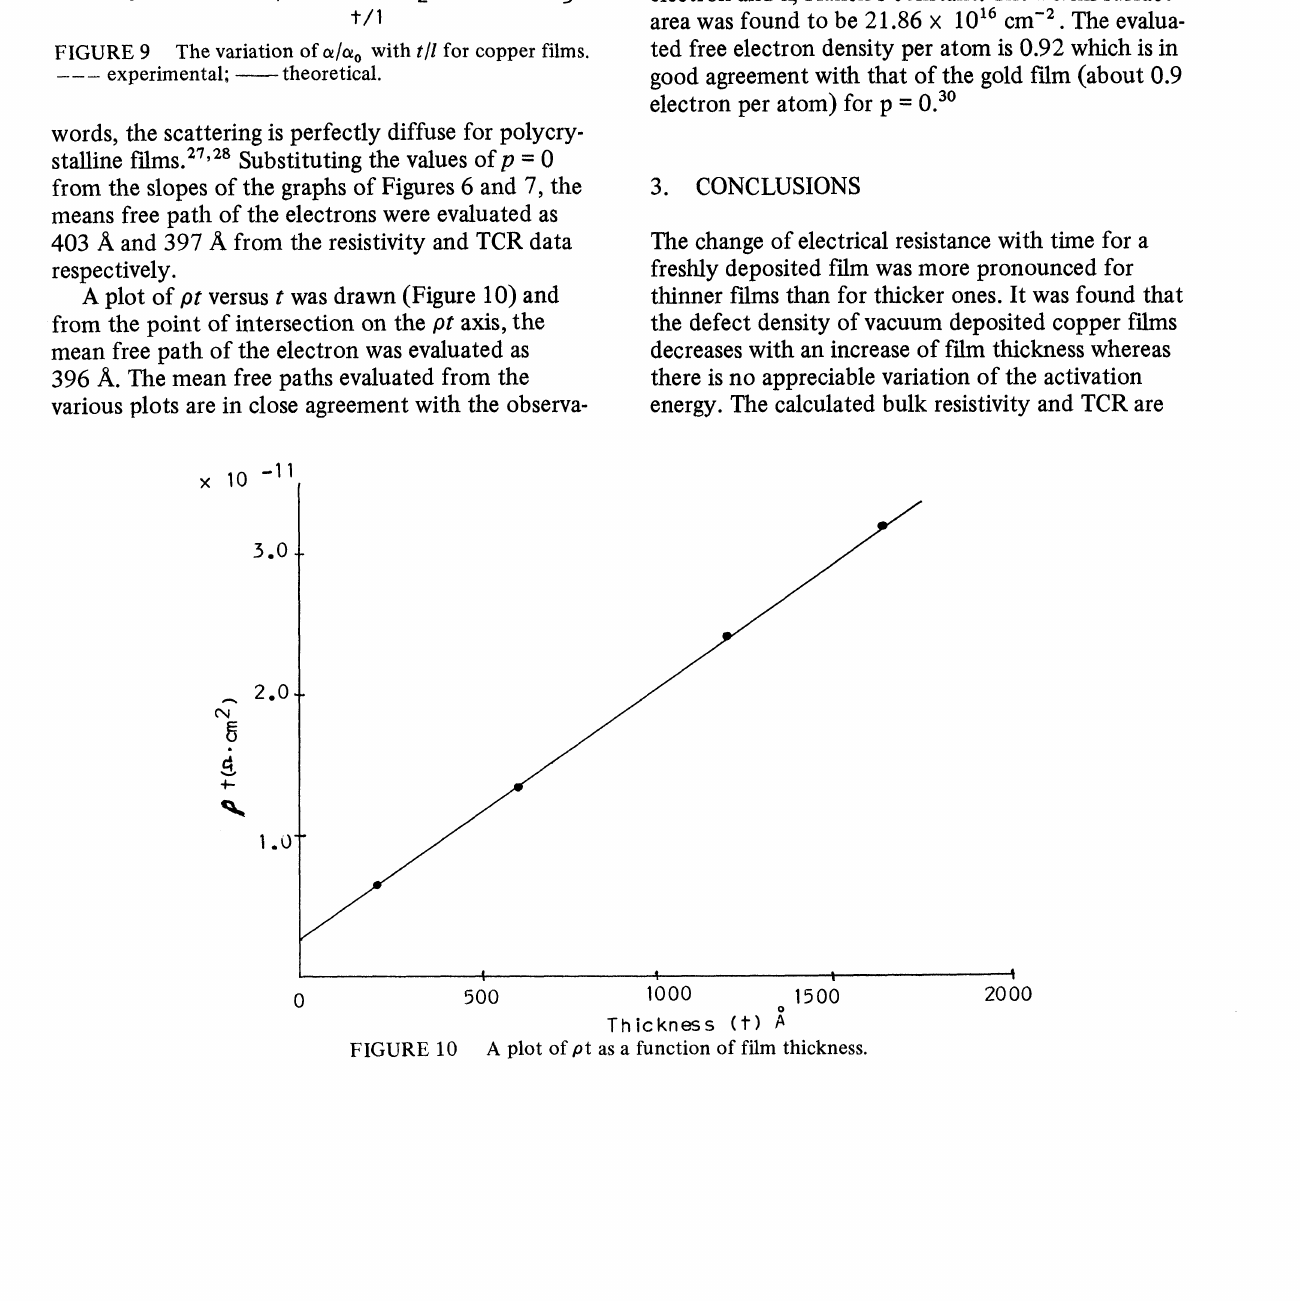
FIGURE 9 The variation of /o with t/l for copper films. experimental: theoretical.